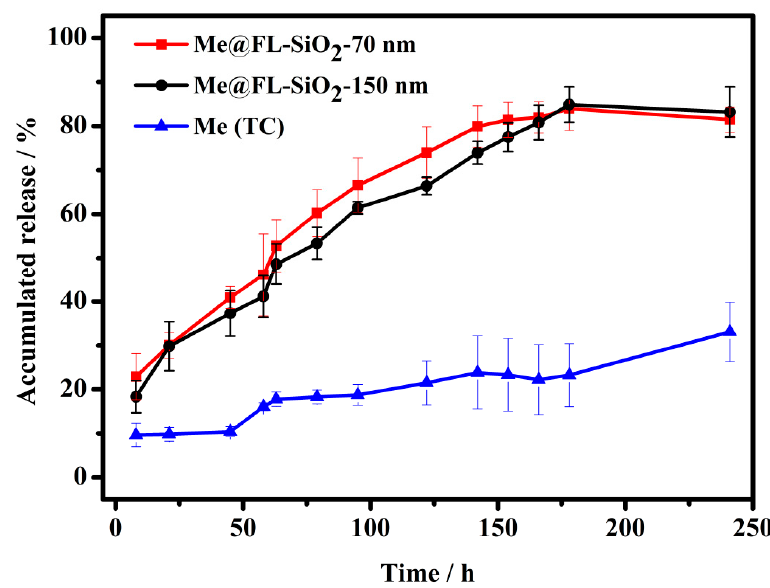
Figure 3. Controlled release profile of methoxyfenozide from Me@FL-SiO 2 NPs under pH 7.5 value. Error bars correspond to standard errors of three measurements.